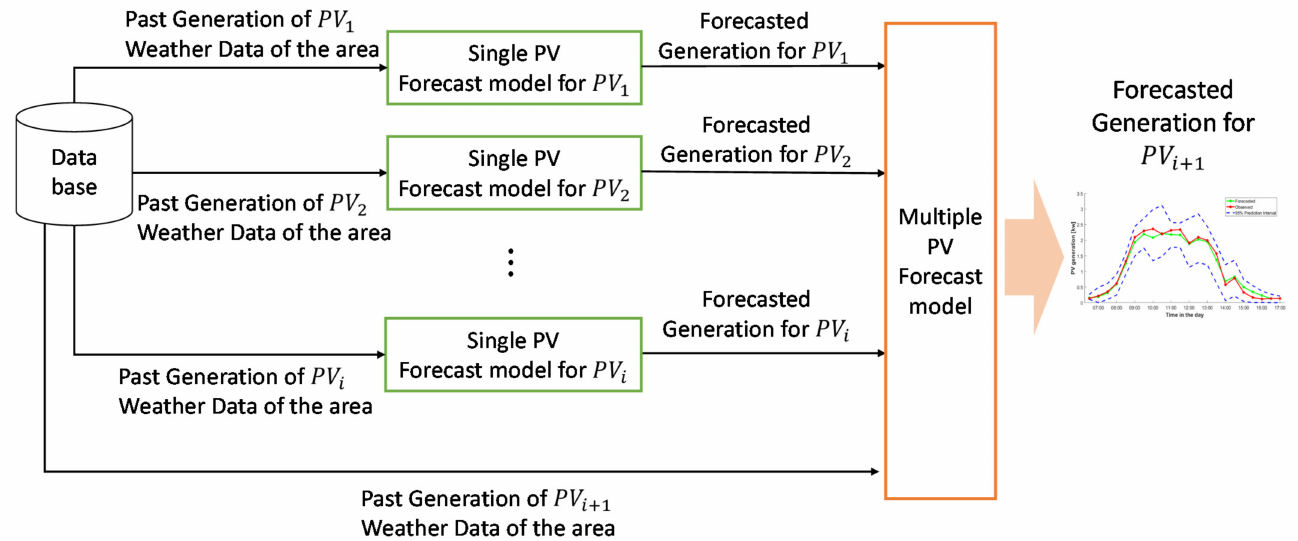
Figure 1. Configuration of the single and multiple PV forecast